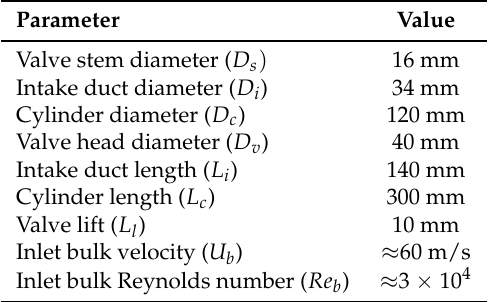
Table 2. Dimensions and flow parameters for the fixed intake valve simulation setup.